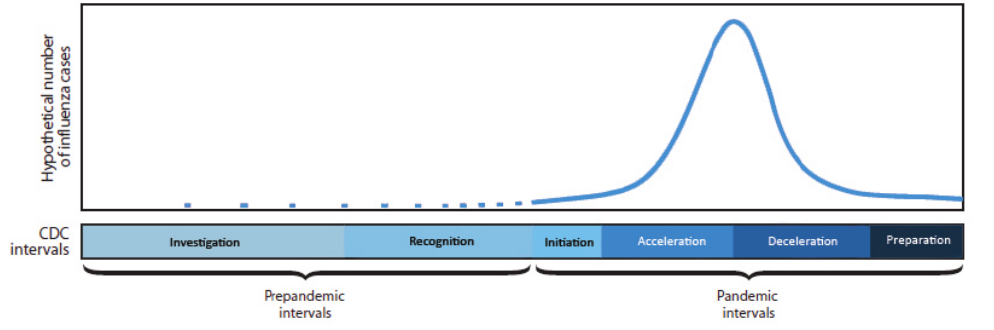
Figure 1. CDC pandemic